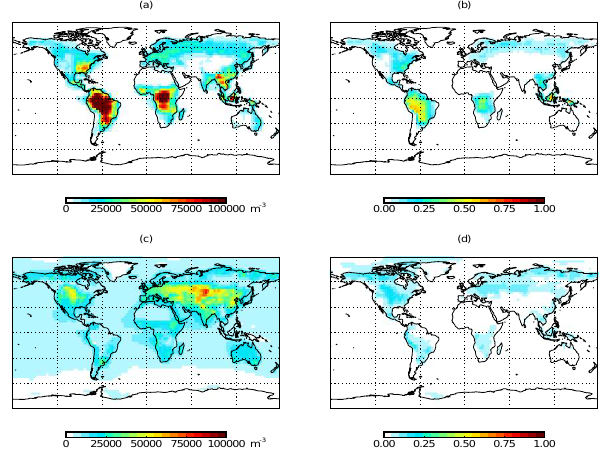
Figure 1. Simulated surface annual mean (a) fungal spore number concentrations, (b) fractional contribution of fungal spores to su- permicron surface number, (c) bacteria number concentrations and (d) fractional contribution of bacteria to supermicron number con- centrations.